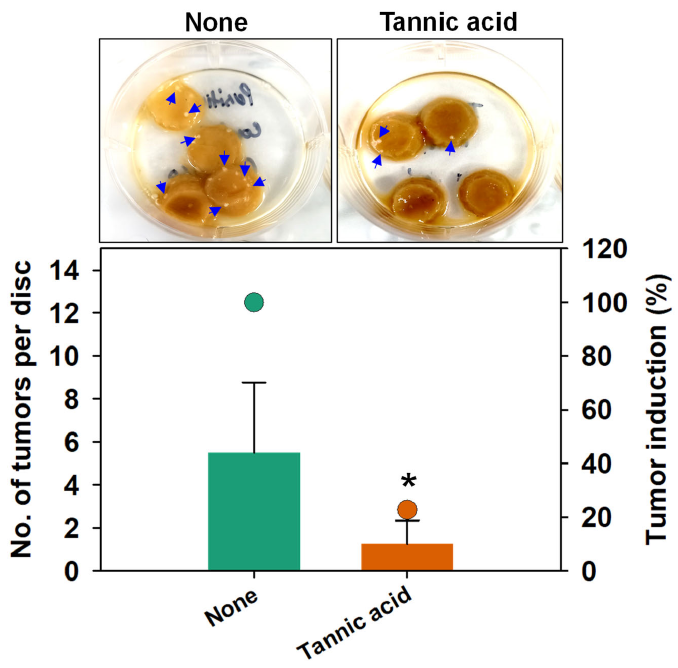
Figure 7. Induction of tumors by A. tumefaciens on potato discs and its inhibition by tannic acid (200 µ g/mL). Bars show numbers of tumors per disc while symbols represent tumor induction (%). Representative pictures of potato discs with tumors marked with blue arrows are shown on the top. Two independent bacterial colonies were used in triplicates ( n = 6), and experiment was repeated twice. ‘*’ shows a significant difference at p ≤ 0.05 by the two ‐ tailed t ‐ test.